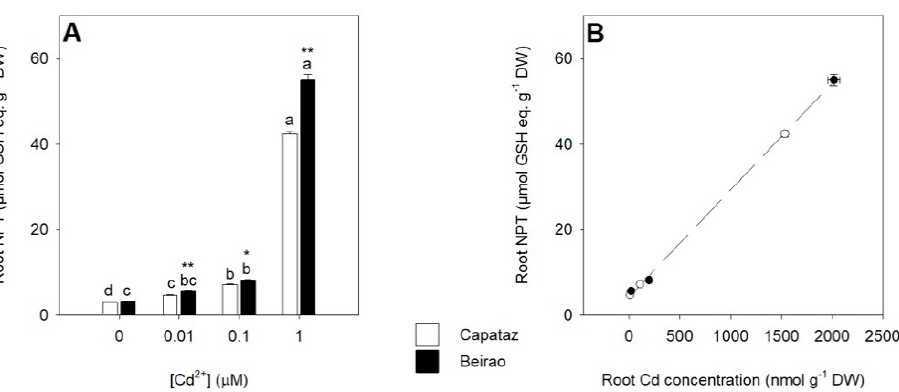
Figure 2. Effect of Cd exposure on non-protein thiol (NPT) accumulation in the roots. Capataz and Beirao were exposed to different Cd concentrations (0.01, 0.1, and 1 μ M) for 10 days. NPT concentrations in the roots of Capataz (white bars) and Beirao (black bars) expressed as GSH equivalents ( A ). NPT concentration as a function of Cd concentration in the roots of Capataz (white circles) and Beirao (black circles) ( B ). Data are means and SE of two experiments run in triplicate (n = 6). Different letters indicate significant differences among treatments ( p < 0.05). Asterisks indicate significant differences between Capataz and Beirao (Student’s t -test; * 0.001 ≤ p < 0.005; ** p < 0.001). DW, dry weight.